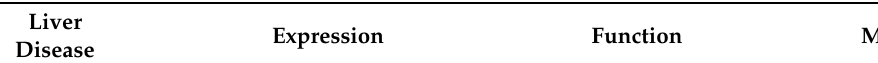
Table 2. Role of PPARs in liver